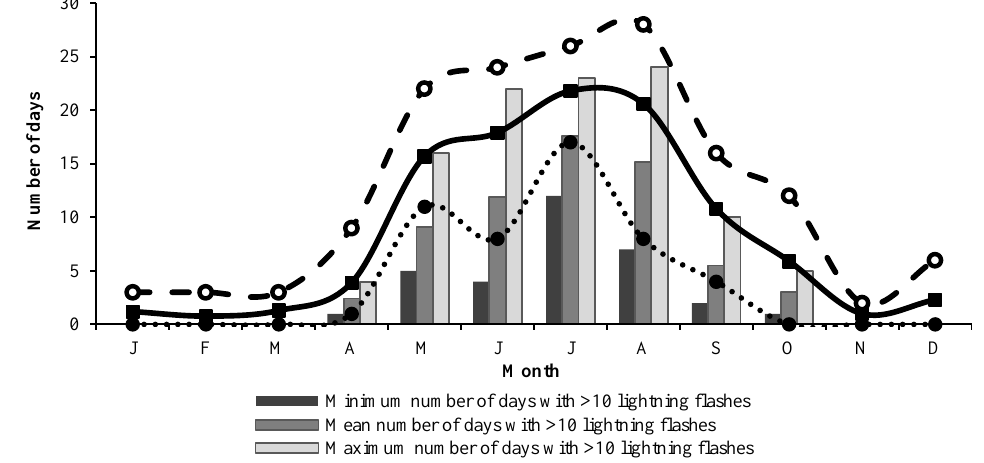
Fig. 2. The seasonal course of the frequency of days with lightning flashes presented as the multi-year mean, minimum and maximum number of days with at least 1 lightning flash and more than 10 lightning flashes detected in Latvia over the period 2006–2015. The monthly distribution of the total number of days with lightning flashes and days with more than 10 lightning flashes observed (Fig. 2) reveals a maximum of lightning activity in the summer season. In general, lightning flashes have been detected in Latvia throughout the year, however on particular years there were no lightning flashes observed during the period between October and March. The time period between May and September can be considered as the period of increased convective activity in Latvia, since the average number of days with lightning detected varies between 11 and 22, with the maximum observed in the summer months (18, 22, 21 days on June, July and August accordingly). At the same time, days with more than 10 lightning flashes have been observed within the period between April and October, with a maximum of on average 18 days detected in July. During years with low convective activity over the country, the number of days with more than 10 lightning flashes detected has not exceeded 12 days per month,